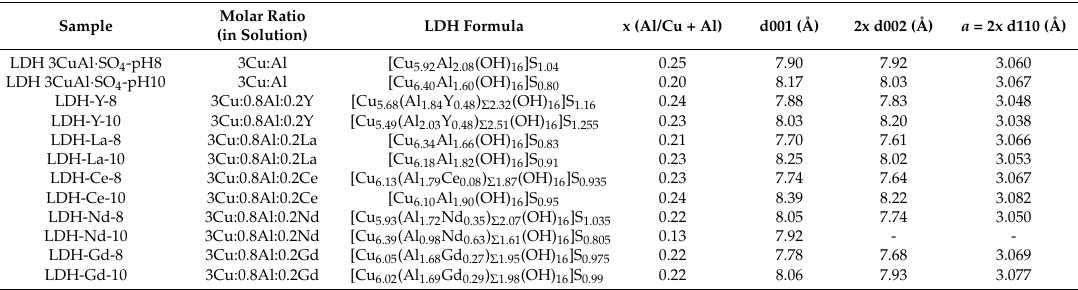
Table 2. Chemical and crystallographic characteristics of synthetic LDH. Sample Molar Ratio (in Solution) LDH 3CuAl · SO 4 -pH8